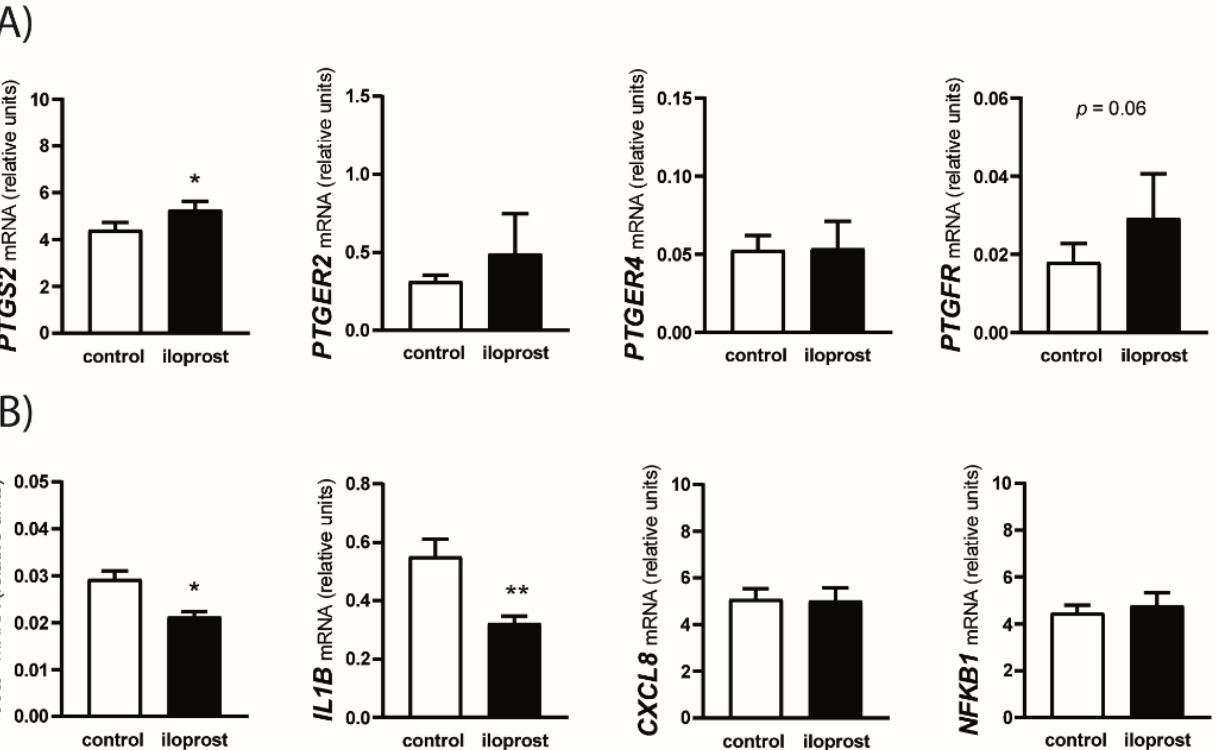
Figure 4. Effect of prostaglandin I2 (PGI2; prostacyclin) analog, iloprost, on the mRNA expression of genes involved in PG synthesis (panel A ; PTGS2 ) and action (panel A ; PTGER2 , PTGER4 , and PTGFR ) and genes involved in the inflammatory response (panel B ; TNF, IL1B, CXCL8, and NFKB1 ) in the myometrium. Myometrial explants were incubated for 8 h without (control) or with 1 µM of iloprost. Values from real-time PCR for each studied mRNA transcript were normalized to geomet- ric averaging of GAPDH and HPRT1 mRNA expression. Data are expressed as the mean ± SEM ( n = 6). Asterisks specify the difference compared with the control value (* p < 0.05; ** p < 0.01).